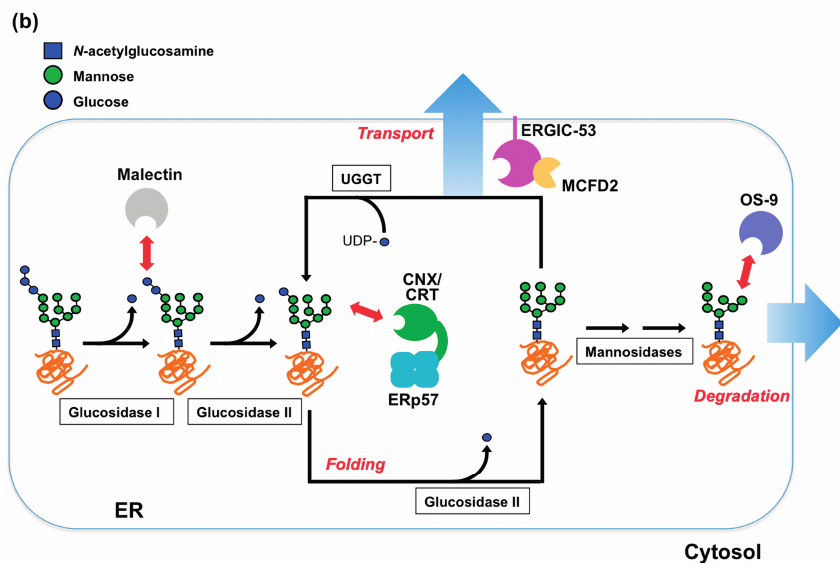
Figure 1. ( a ) Schematic representation of Glc 3 Man 9 GlcNAc 2 indicating the nomenclature of oligosaccharide residues and branches according to the custom stated by Vliegenthart et al . [1]; ( b ) Scheme of N -glycan-dependent fate determination of glycoproteins in the